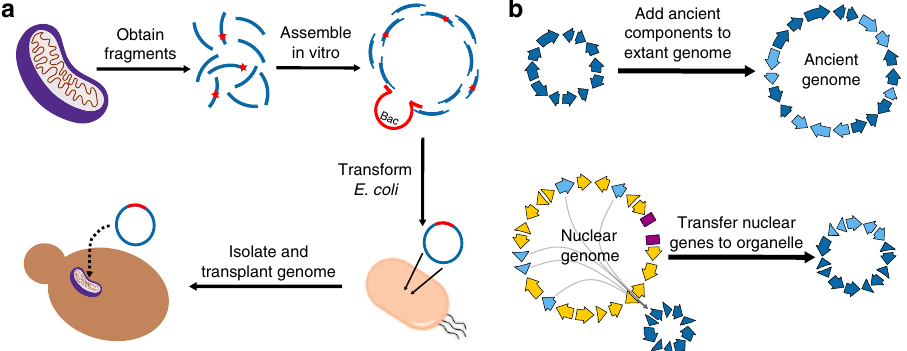
Fig. 6 Organelle reengineering. a Organellar genomes can be constructed by harvesting and modifying natural genetic material or by performing de novo synthesis 113 . b Synthesis of organellar genomes can be used to study a number of problems, including, but not limited to, the early evolutionary stages following endosymbiosis and cytonuclear genetic interactions. Note: the purple rectangles represent